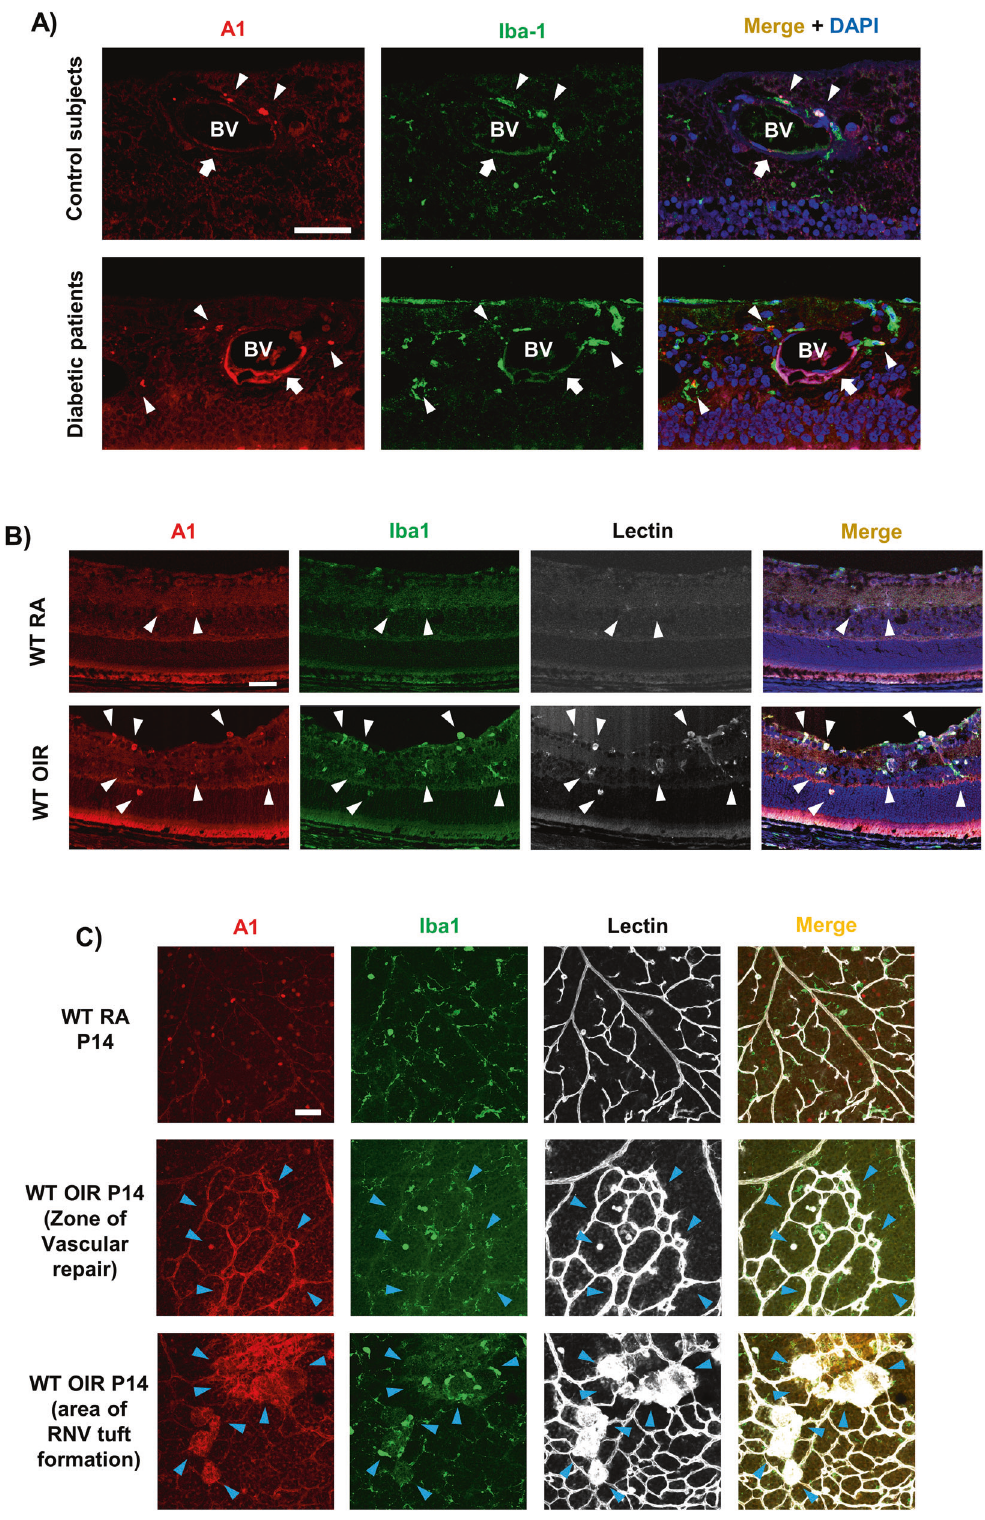
Fig. 6 A1 is upregulated in human DR and mouse OIR retinal sections. A Immunolabeling of retina sections from human donor with PDR showed increased co-localization of A1 with Iba-1 and blood vessel (BV)-like structures as compared with non-diabetic control. Scale bar = 50 µm. B Immunolabeling of P17 mouse retina sections showed co-localization of A1 with Iba-1-positive myeloid cells (microglia/ macrophages) and lectin-positive blood vessels after OIR. Scale bar = 20 µm. C Immunolabeling of mouse retina fl atmount at P14 showed A1 upregulation and co-localization with Iba-1-positive microglia/macrophages and lectin-positive blood vessels in both the areas of vascular repair (VR) and RNV tufts (RNV). Scale bar = 20 µm.